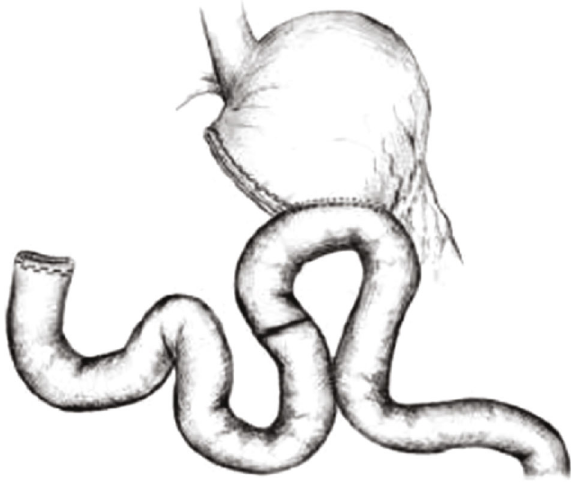
Figure 1: Anastomosis of gastric jejunum uncut